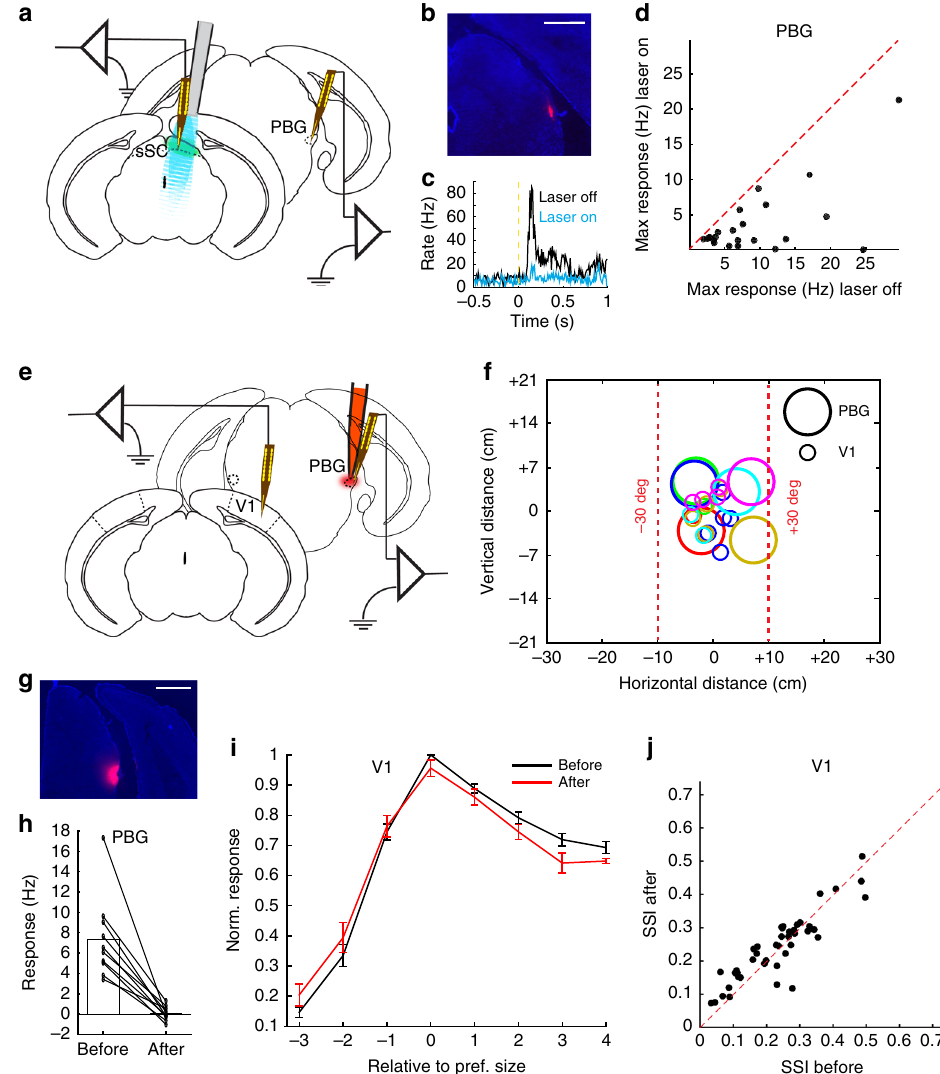
Fig. 4 Effect of sSC on V1 is not mediated by PBG. a Laminar recording electrode in the PBG of anesthetized Gad2-cre mouse, expressing channelrhodopsin-2 in the sSC, with a laser-coupled fi ber placed above the sSC. b Coronal slice showing trace of DiI (red) from the recording electrode in PBG. DAPI in blue. Scale bar is 0.5 mm. c Example peristimulus time spike histogram in the PBG, without and with optogenetic inhibition of the sSC. d Maximum response to full screen gratings in PBG was reduced by optogenetic inhibition of the sSC ( p = 4 × 10 -5 , Wilcoxon test, 4 mice, 22 units). e Laminar recording electrodes in V1 and the PBG, before and after injection of fl uorescent muscimol in the PBG, in the anesthetized mouse. f Receptive fi eld centers of recorded units in V1 and the PBG for this set of experiments. Colors represent the different experiments. Receptive fi eld sizes are not indicated. g Coronal slice showing fl uorescent muscimol in the PBG. DAPI in blue. Scale bar is 0.5 mm. h Muscimol silenced the PBG ( p = 0.002,